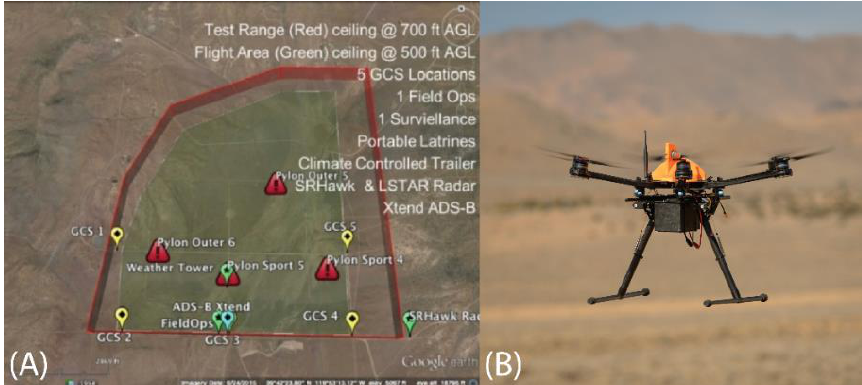
Figure 10. ( A ) NASA TCL2 campaign at Reno-Stead, October 2016 [23] and ( B ) ACUASI Ptarmigan S800 UAS. [23].